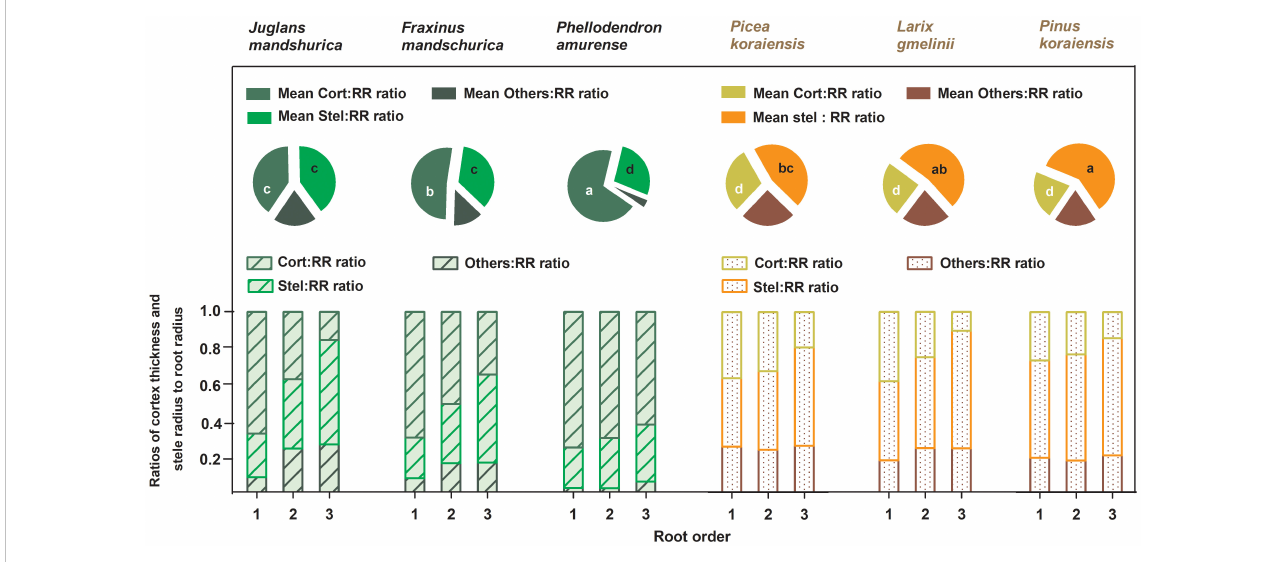
FIGURE 2 Ratios of unilateral cortex thickness (Cort : RR ratio), stele radius (Stel : RR ratio) and unilateral cross-sectional length of the other components (Others : RR ratio) to root radius for the fi rst three absorptive root orders within three angiosperms and three gymnosperms tree species ( n = 30). For each order root per species, mean ratios of unilateral cortex thickness (Mean Cort : RR ratio), stele radius (Mean Stel : RR ratio) and unilateral cross-sectional length of the other components (Mean Others : RR ratio) to root radius were calculated across root orders, respectively ( n = 30). Different white and black lower-case letters on the pie chart indicate signi fi cant differences ( p < 0.05) in Mean Cort : RR ratio and Mean Stel : RR ratio among six species,